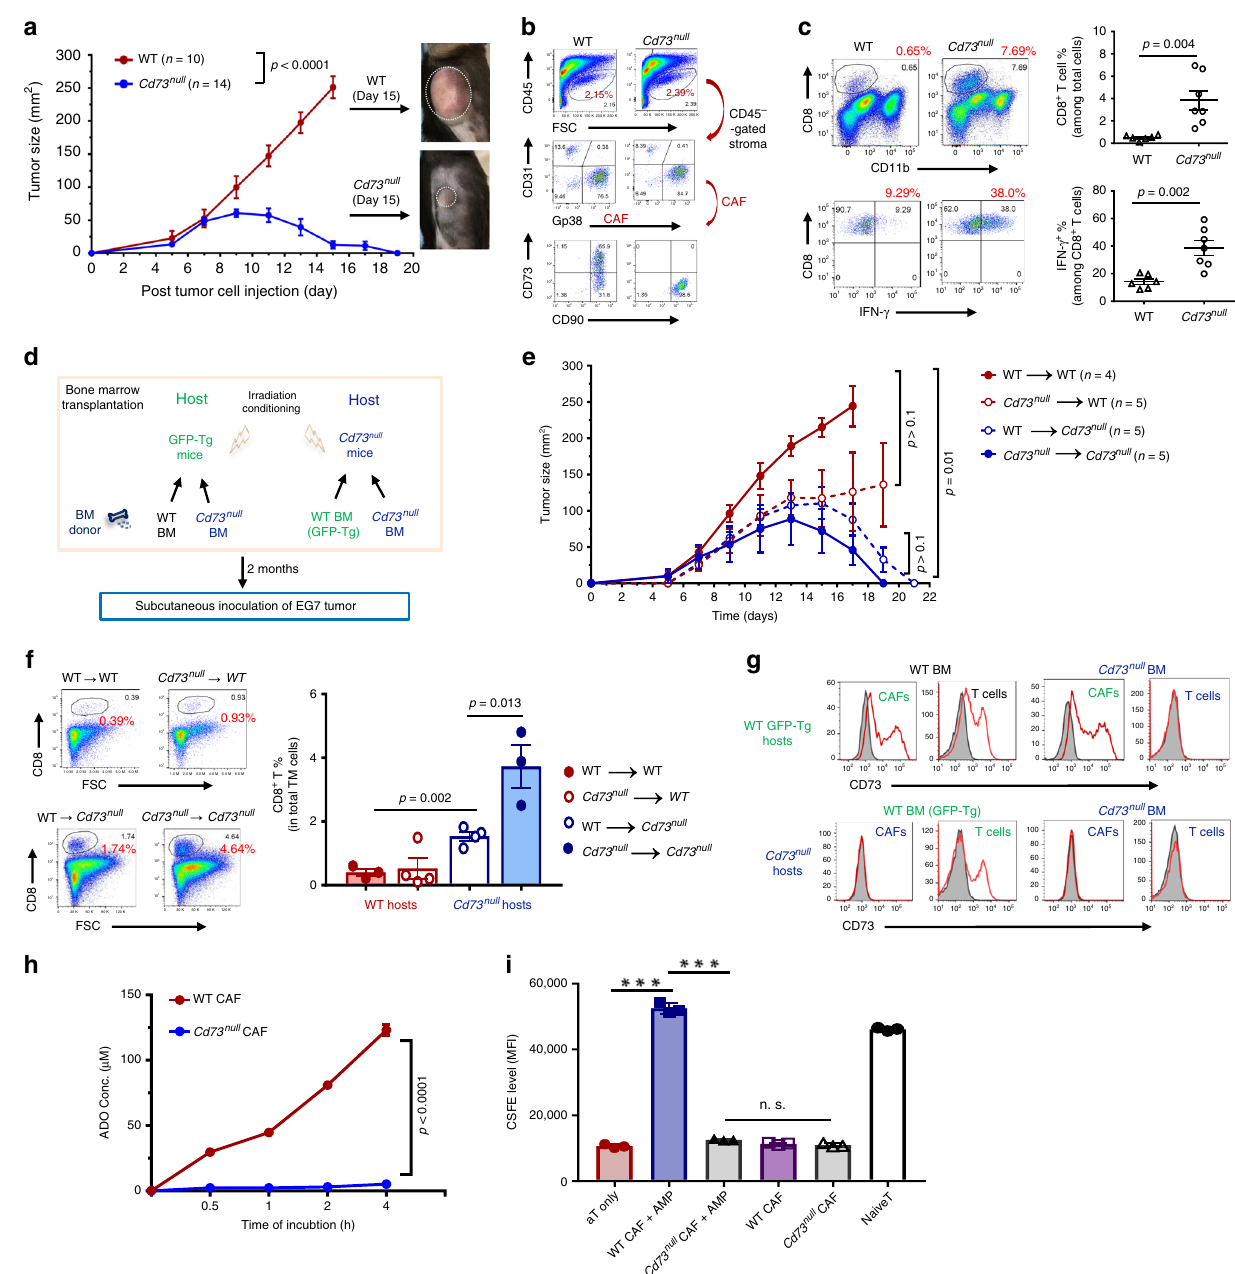
Fig. 4 Cd73 inactivation in the non-hematopoietic compartment hinders tumor progression causing tumor regression. a C57BL/6 WT and Cd73 null mice received 1 × 10 6 EG7 tumors s.c. were monitored for tumor progression every other day. Representative images illustrate the tumor size in WT and Cd73 null mice at 15 days post-inoculation. b At 9 days post-EG7 inoculation, tumors were collected from WT and Cd73 null mice for analysis of EG7-CAF percentage and phenotype. c The percentage of tumor in fi ltrating CD8 + T cells and IFN- γ + effectors in the EG7 TME of WT and Cd73 null mice were analyzed, summarized, and shown to the right. d Schematic diagram shows reciprocal BMT strategy between WT C57BL/6 (GFP-Tg) and Cd73 null mice. e Two months post-BMT, EG7 tumors were established s.c. in these BMT mice and tumor progression was examined every other day. f Representative FACS plots (left) and summary (right) of tumor-in fi ltrating CD8 + T cells in the BMT mice are presented. g The representative histograms show CD73 expression (red line) compared with isotype control (gray) in CAFs and T cells of the BMT mice. h EG7-CAFs from WT and Cd73 null mice were puri fi ed via FACSort. Their capacity and kinetics for ADO conversion from 200 μ M AMP was determined. i The capacity of WT and Cd73 null CAF-conditioned medium in the absence (CAF-CM) or presence of 200 μ M AMP (AMP-CAF-CM) for inhibiting T cell proliferation as CFSE dilution was examined. Data depict mean ± SEM. Student ’ s t -test. n = 5. Source data are provided in the Source Data fi